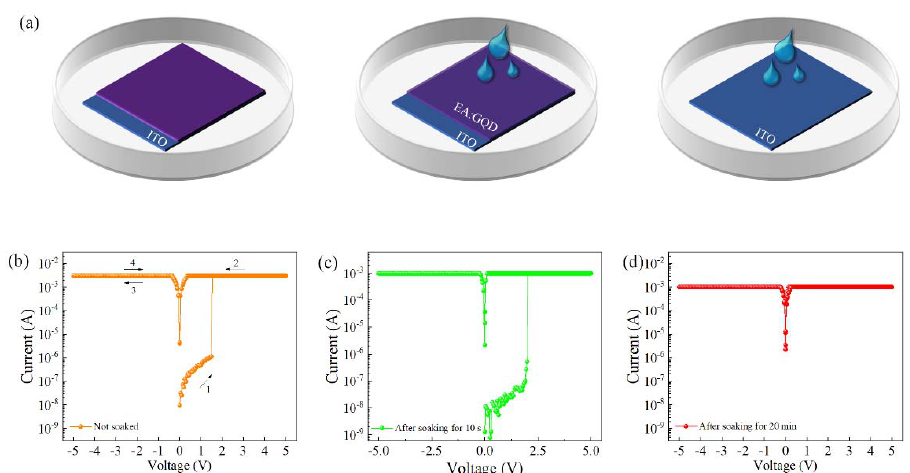
Figure 5. ( a ) Schematic diagram of the device placed in deionized water; I–V characteristic curves of the Al/EA:GQD/ITO/PET device. ( b ) Without soaking. ( c ) After soaking for 10 s. ( d ) After soaking for 20 min. Nanomaterials 2022 , 12 , x FOR PEER REVIEW